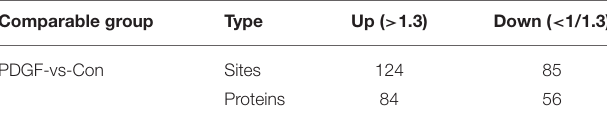
TABLE 6 | Statistical information of differentially expressed modification level of ubiquitinomics. Comparable